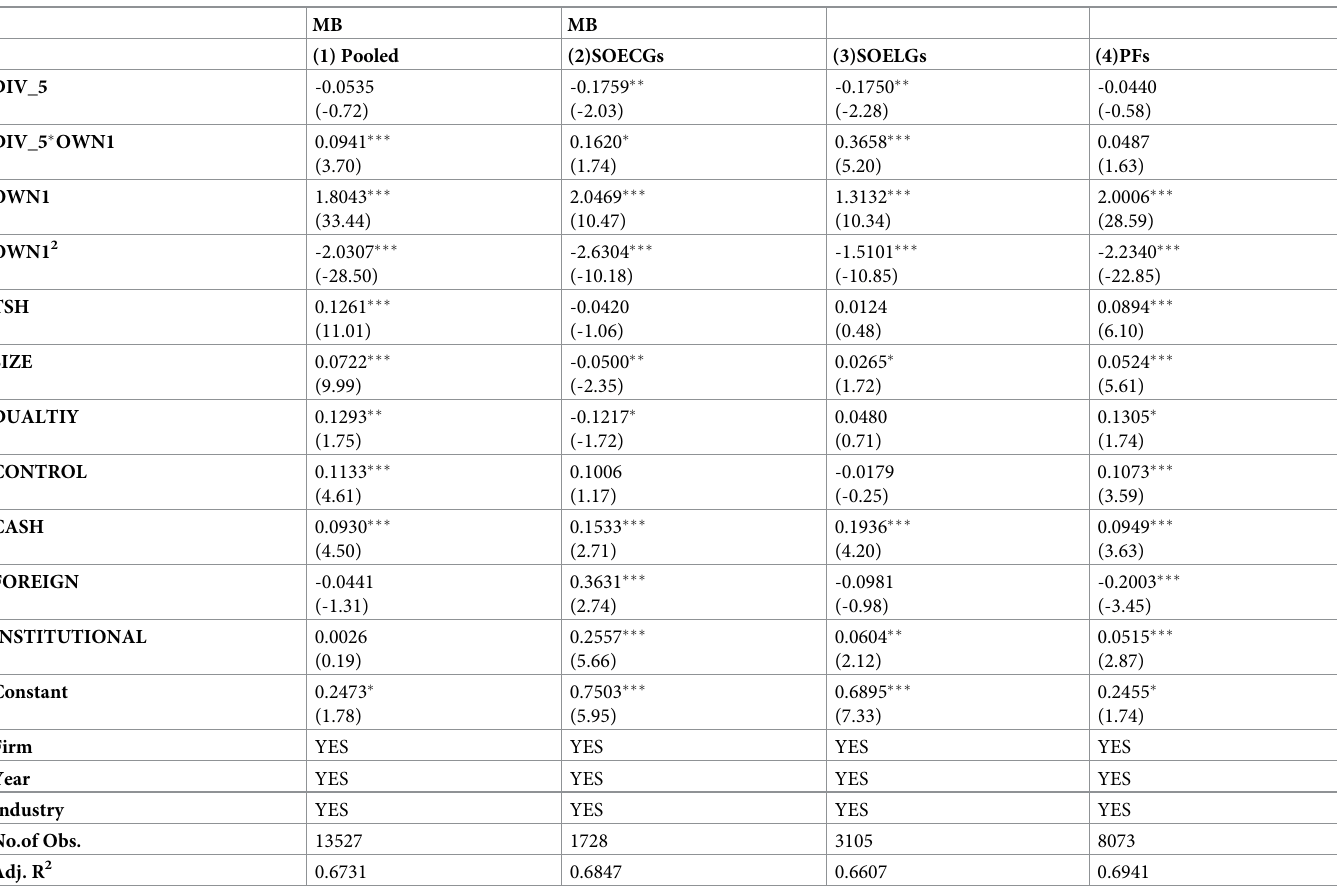
Table 6. Robustness test: Firm-fixed effect